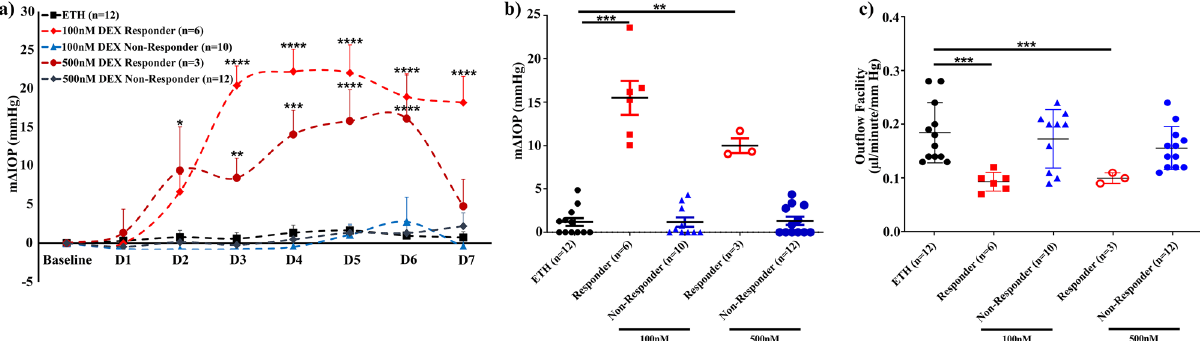
Figure 1. Effect of DEX on IOP. ( a ) The mean ± SEM of ∆IOP of ETH (vehicle control), DEX-treated responder and non-responder eyes were plotted over time. The eye pressure of the anterior segments in culture was acquired using Power Lab data acquisition system (AD Instruments, NSW, Australia) and analyzed using LabChart Pro software (ver.8.1) as described in detail in methods section. The basal IOP on day 0 (before DEX treatment) was set at 0 mmHg. In 100 nM dose group, treatment with DEX showed a significant elevated IOP in 6/16 eyes (Mean ± SEM—mΔIOP: 15.50 ± 1.96 mmHg; Response rate: 37.5%) whereas in 500 nM dose group, 3/15 eyes showed a very significant elevated IOP (Mean ± SEM—mΔIOP: 10 ± 0.84 mmHg; Response rate: 20%). ETH treated eyes showed mean ± SEM—mΔIOP of 0.92 ± 0.54 mmHg. Data were analyzed by unpaired 2-tailed Student’s t test on each treatment day. * p < 0.05; ** p < 0.001; *** p < 0.0001; **** p < 0.00001. Frequency Plot of the ( b ) IOP data and ( c ) Outflow facility data. The m∆IOP and outflow facility of ETH treated, DEX-responder and DEX-non-responder groups were plotted for both 100 and 500 nM dose groups. The m∆IOP was increased after DEX treatment in responder eyes as compared to non-responder and ETH-treated eyes whereas outflow facility was decreased significantly after DEX treatment (100 and 500 nM) in responder group as compared to non-responder and ETH-treated groups.